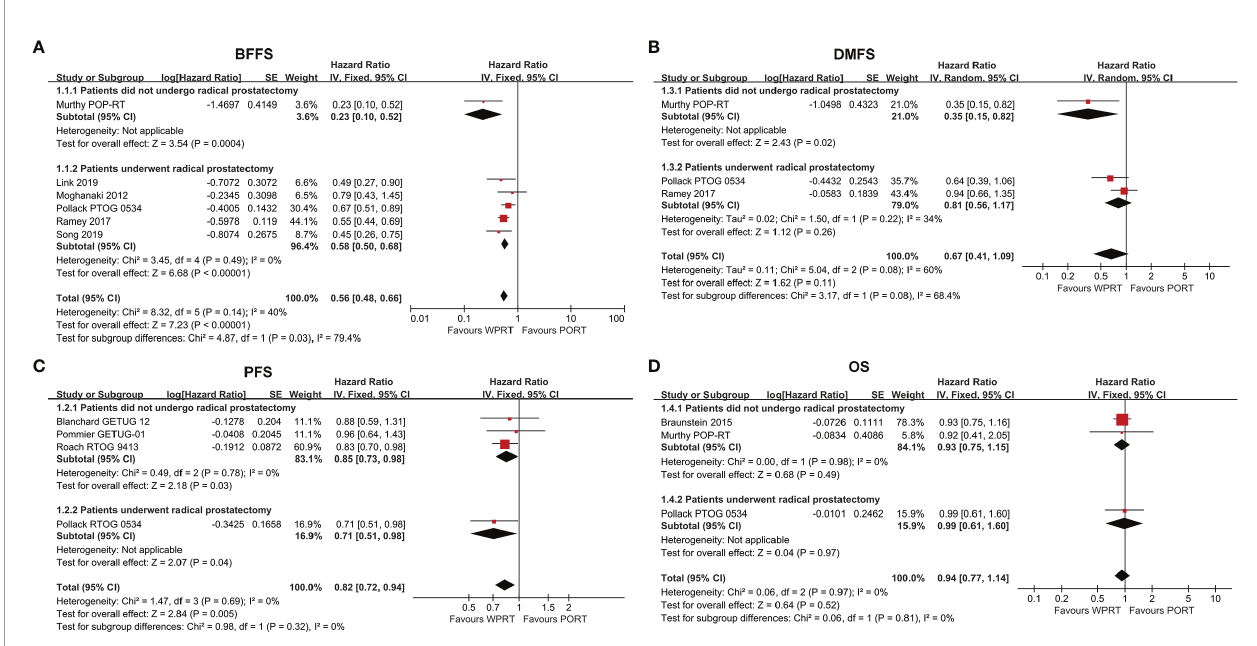
FIGURE 2 | Forest plots of BFFS (A) , PFS (B) , DMFS (C) and OS (D) . CI, con fi dence interval; WPRT, whole-pelvic radiotherapy; PORT, prostate-only radiotherapy; BFFS, biochemical failure-free survival; PFS, progression-free survival; DMFS, distant metastasis-free survival; OS, overall survival. TABLE 2 | Subgroup analysis of other potential heterogeneity factors for survival outcomes in non-prostatectomy studies. Heterogeneity factors Hazard ratio (95% CI) WPRT vs. PORT p- Value p -Value for Interaction I 2 (%) Age > 66 for PFS Yes 0.77 [0.60,